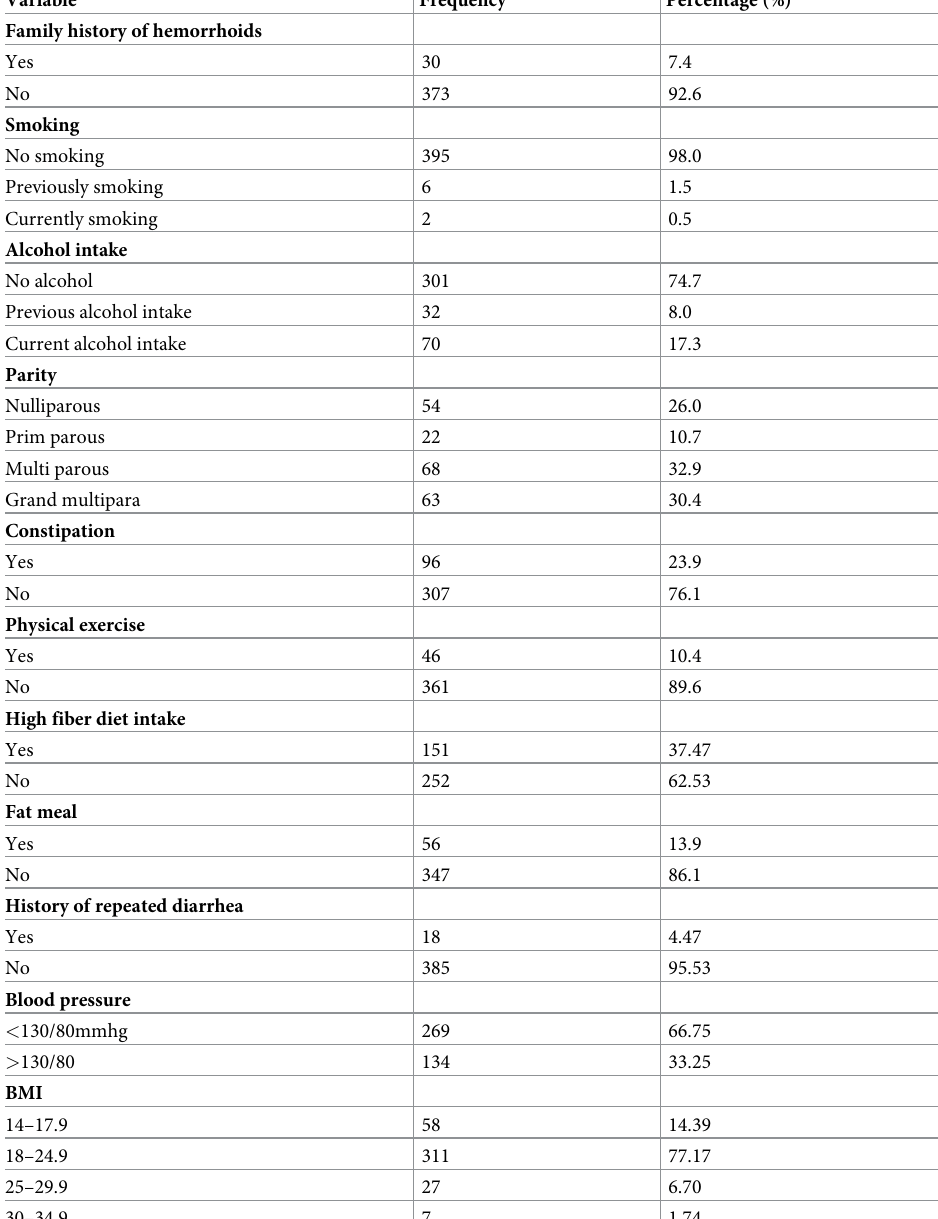
Table 2. Clinical, behavioral and obstetric characteristics of adult patients visiting surgical OPD at the UOG Comprehensive Hospital, Ethiopia, 2020 (n = 403). Variable Frequency Percentage (%) Family history of